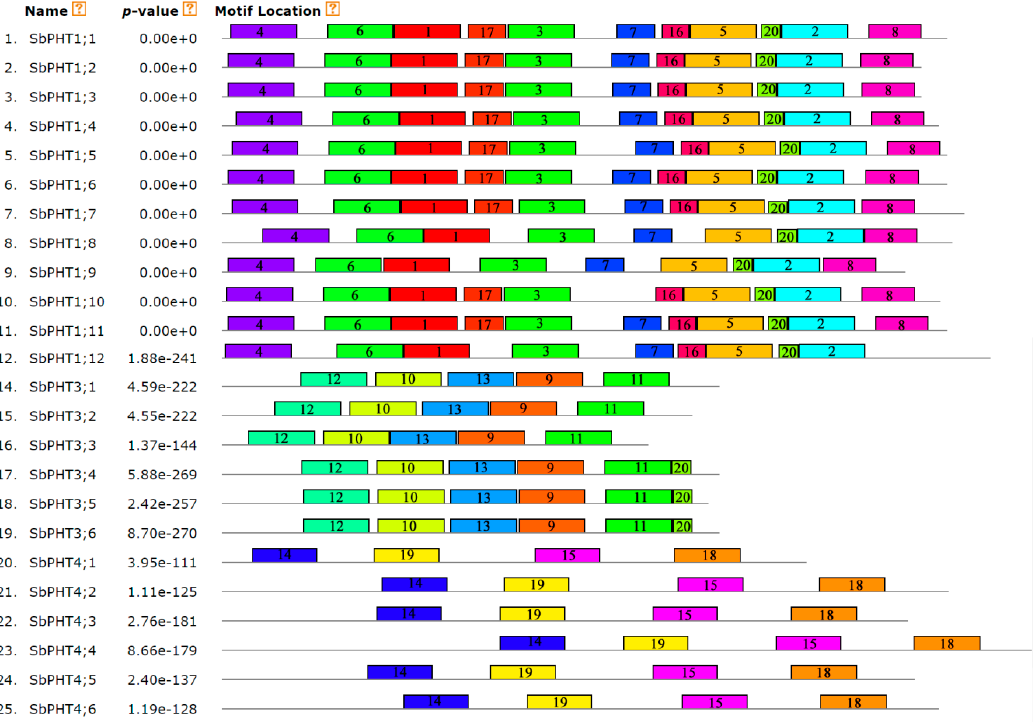
Figure 4. Analysis of the conserved motifs in the full-length Sorghum PHT proteins with the MEME 233 program v5.0.3. 234